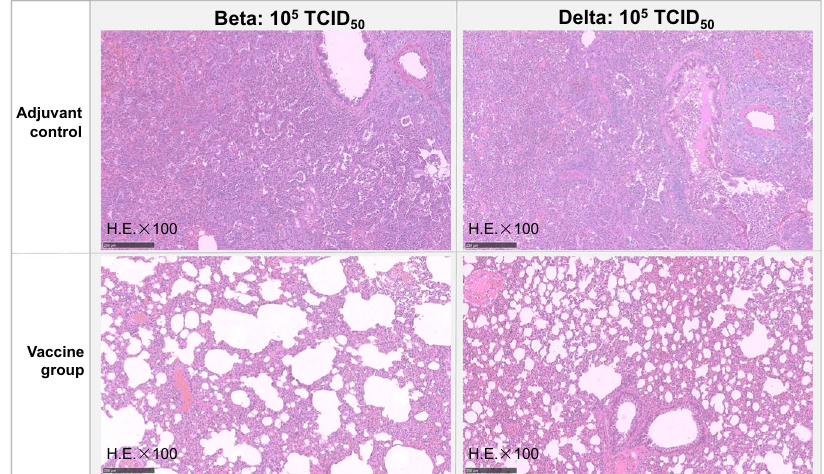
Fig. 6 Lung pathology of adjuvant and vaccine groups in hamsters. Hamsters in each group infected with 10 5 TCID 50 of Beta strian virus, and 10 5 TCID 50 of Delta strian virus. Note: Microscope images were taken at 100 magni fi cation (H.E × 100). The scale bar sizes for the microphotographs are 250